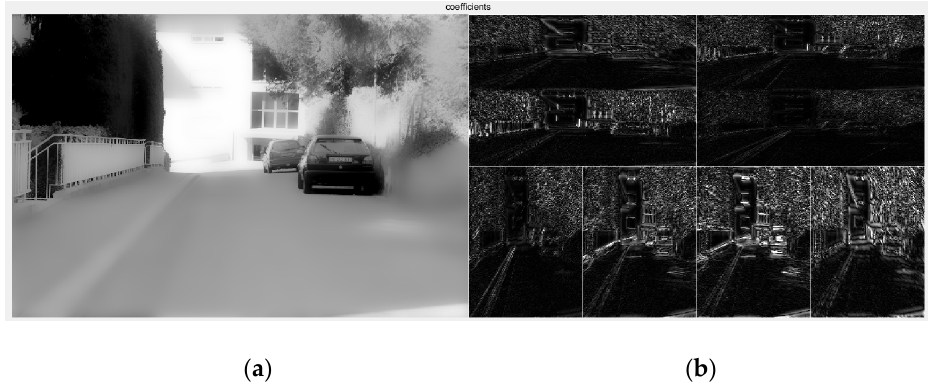
Figure 3. Result of the base and edge images decomposed by contourlet transform: ( a ) base and ( b ) edge images (eight directions).